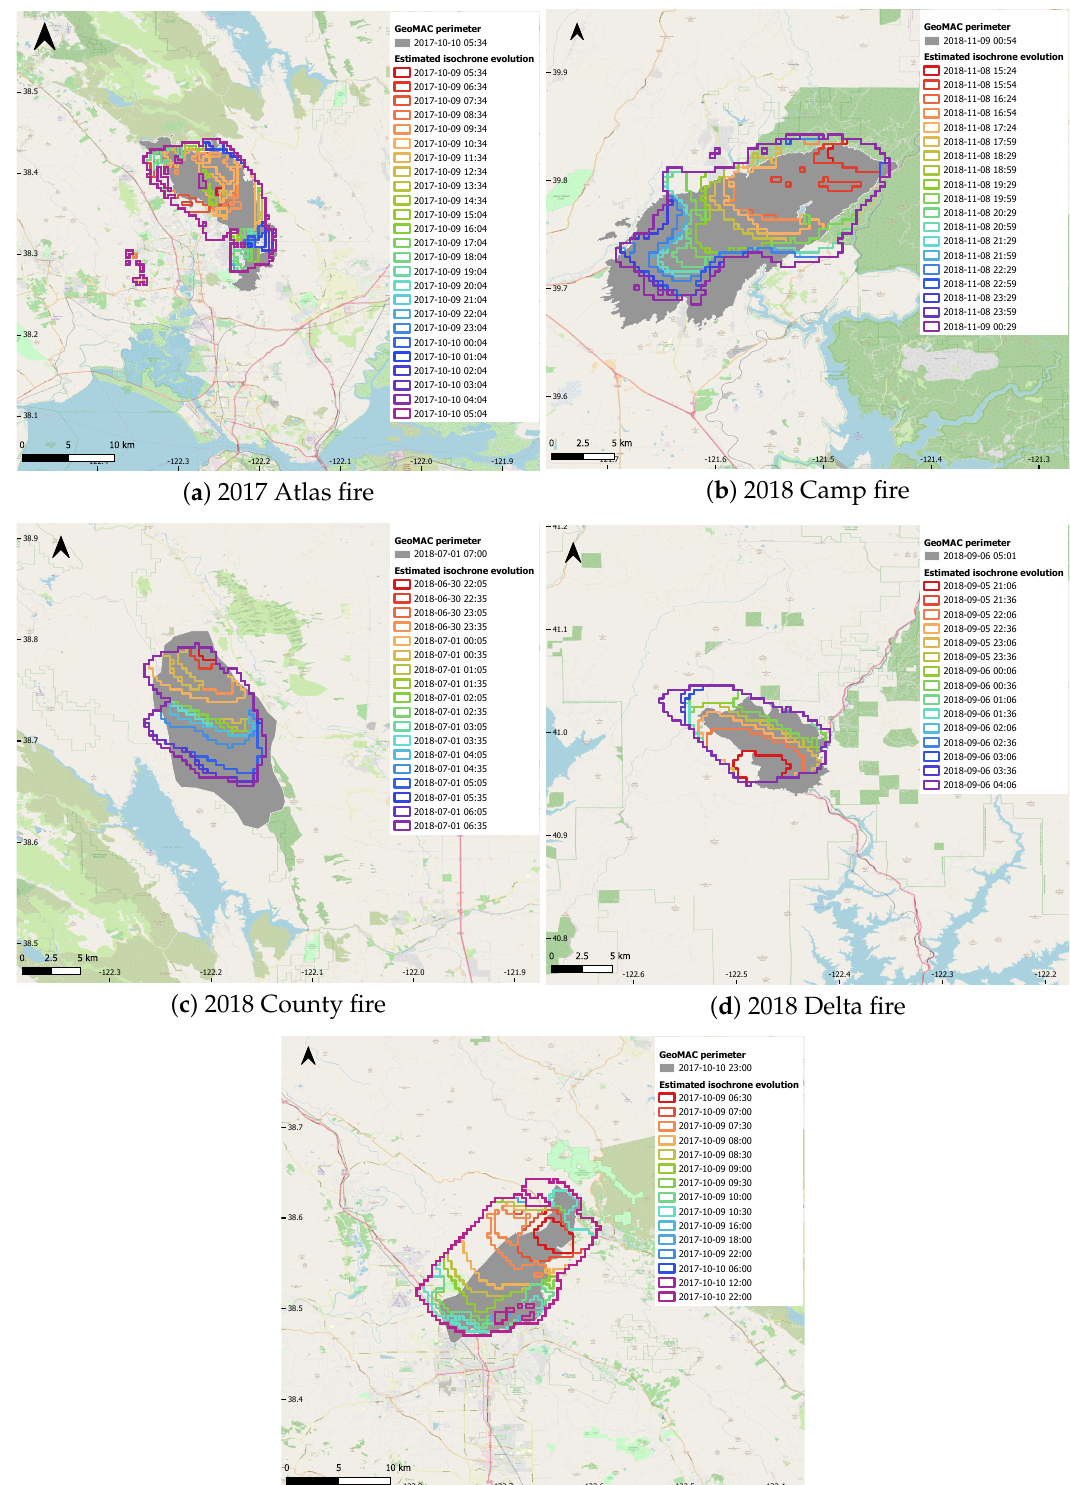
Figure 3. Half-hourly fire progression estimated using the proposed algorithm (color lines), compared against the first perimeter available in GeoMAC (grey polygon). Some intermediate isochrones have been hidden for visualization purposes. All times are UTC. Background map provided by OpenStreetMap